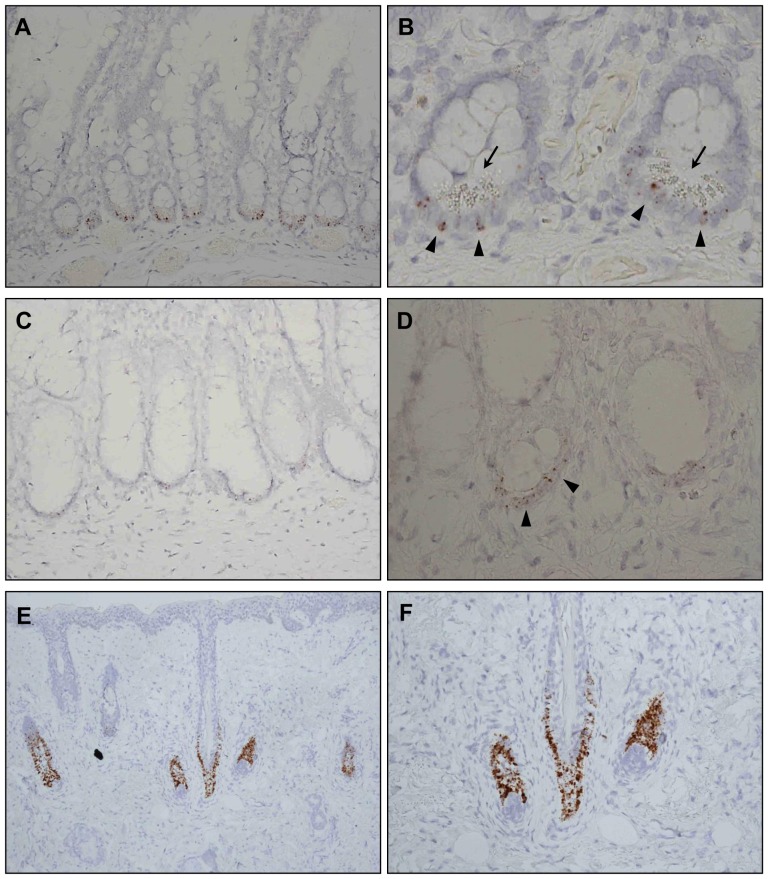
Validation of RNA in situ hybridization (ISH) for the identification of LGR5
+ cells in established niches in normal human tissues.RNA ISH was performed to detect LGR5-expressing cells in formalin-fixed and paraffin-embedded small intestine, colon, and hair follicle samples. LGR5
+ cells are indicated by the brown colored dots. (A) LGR5
+ cells were observed at the base of all small bowel crypts. (B) LGR5
+ cells, indicated by arrowheads, were located next to or between Paneth cells, which are distinguished by their characteristic cytoplasmic granules and marked by arrows. (C, D) LGR5
+ cells in the colonic crypts had lower LGR5 expression than LGR5
+ cells in the small intestine. (E, F) Many LGR5
+ cells were noted in the hair follicle bulges. Magnifications: A, C, F, ×200; B, D, ×400; E, ×100.